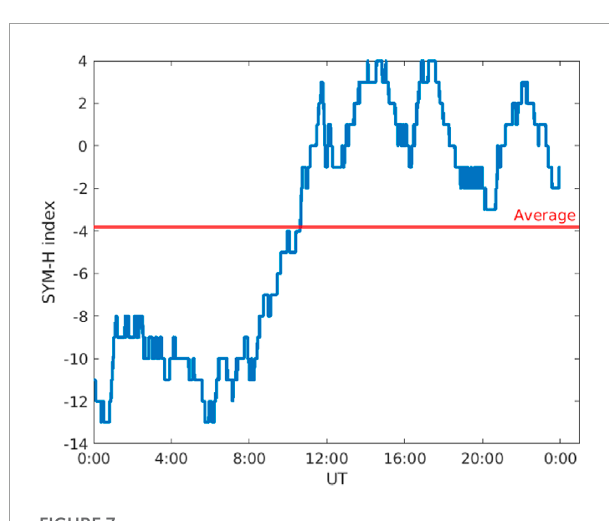
FIGURE 7 SYM-H index for 14 Aug 2021. Following the procedure described in Section 2.2 , this day can be classified as disturbed, in spite of SYM-H going slightly below 10 nT for a few hours.